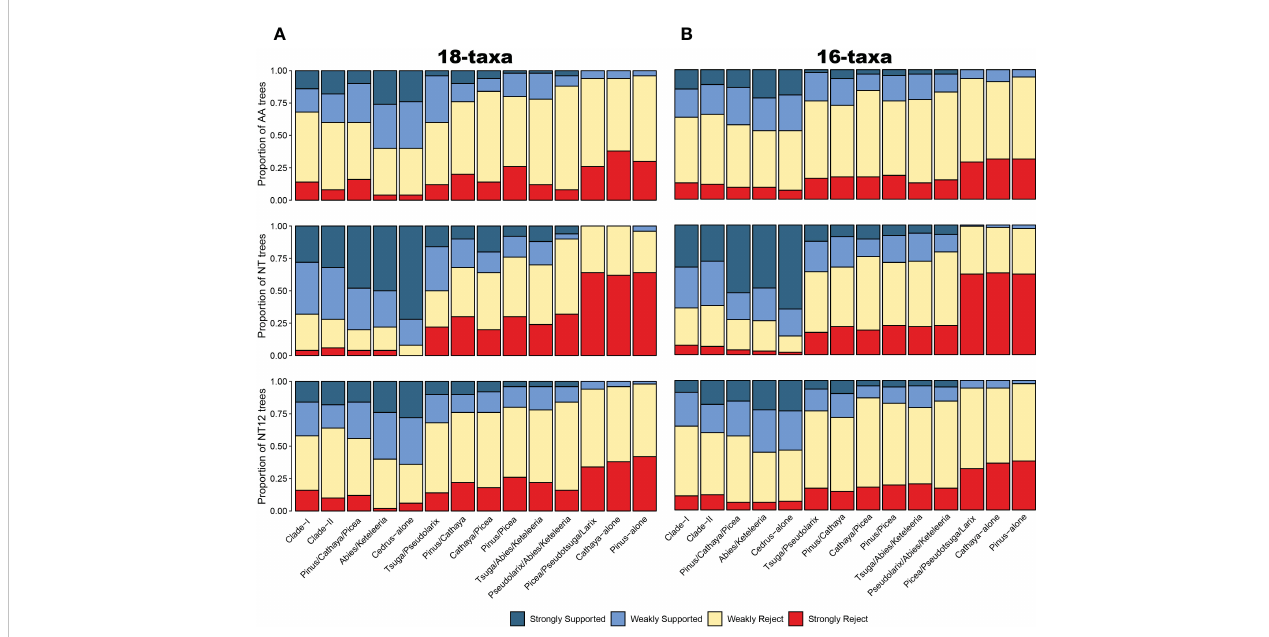
FIGURE 2 Gene tree analysis. The portion of ML gene trees for which important clades (x-axis) are highly (weakly) supported or rejected for the 54 single-copy orthologous gene dataset (A) and 120 single-copy orthologous gene dataset (B) and for AA datasets (upper), nucleotide datasets (middle), and 1st+2nd codon position datasets (below). AA: amino acid sequences; NT: nucleotide sequences; NT12: 1st+2nd codon positions. Weakly rejected clades are those that are not in the tree but are compatible if low-support branches (below 75%) are